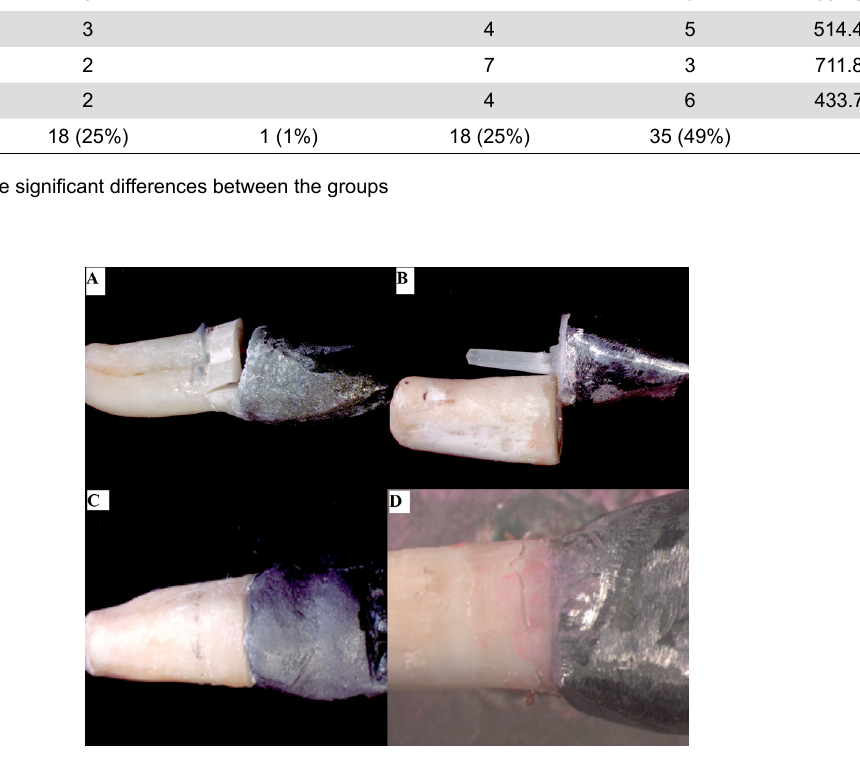
Figure 4- Representative images of failures during mechanical cycling. (A): Unfavorable fracture of specimen without remaining coronal structure. (B): Adhesive failure of the post. (C): Adhesive failure of the crown (displacement crown/core/post); (D) Fracture favorable of the remaining tooth structure